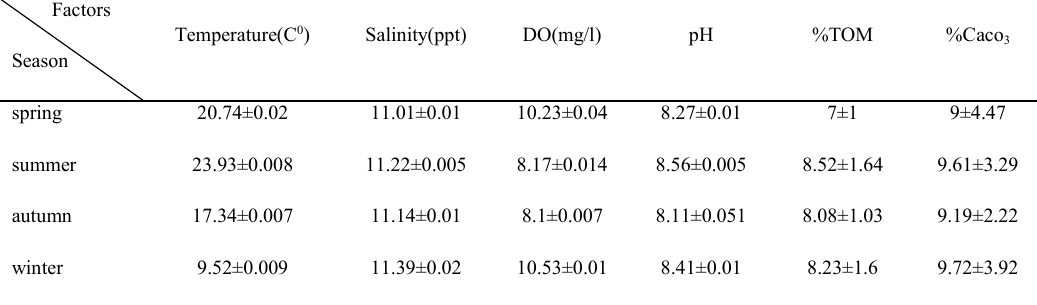
Table 2: The Mean of Temperature, Salinity, DO, pH, Total Organic Matter (TOM) and Caco3 in different Seasons the southern Caspian Sea from Behshahr to Ramsar